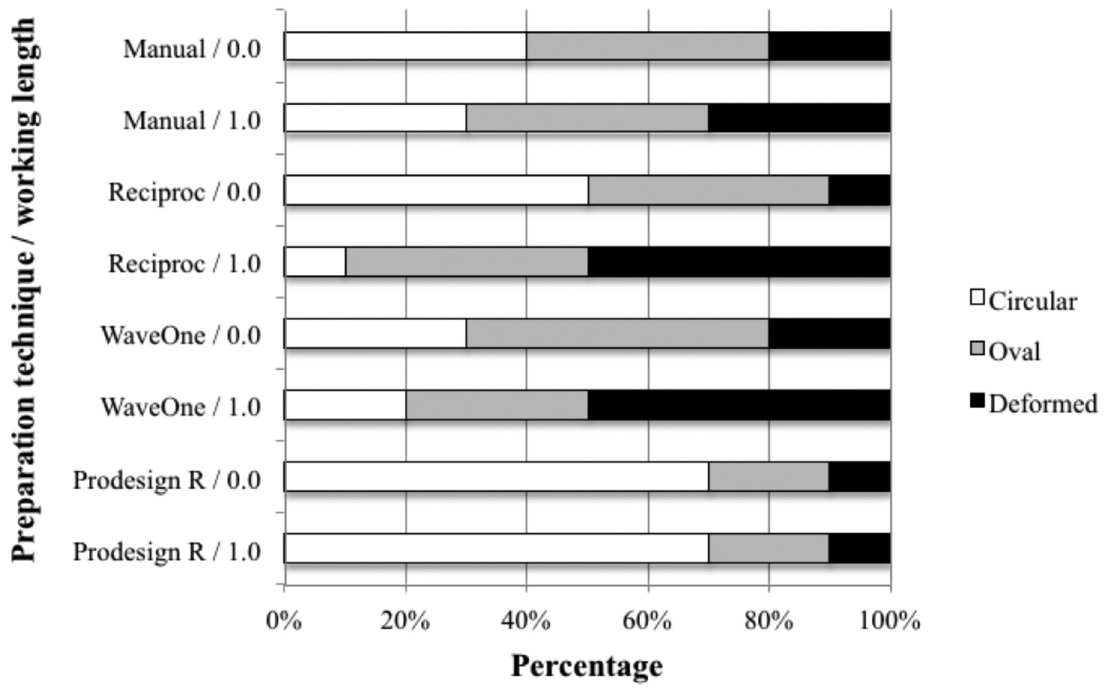
Figure 2- Graphical representation of the occurrence of apical foramen configurations after mechanical preparation using different techniques and working